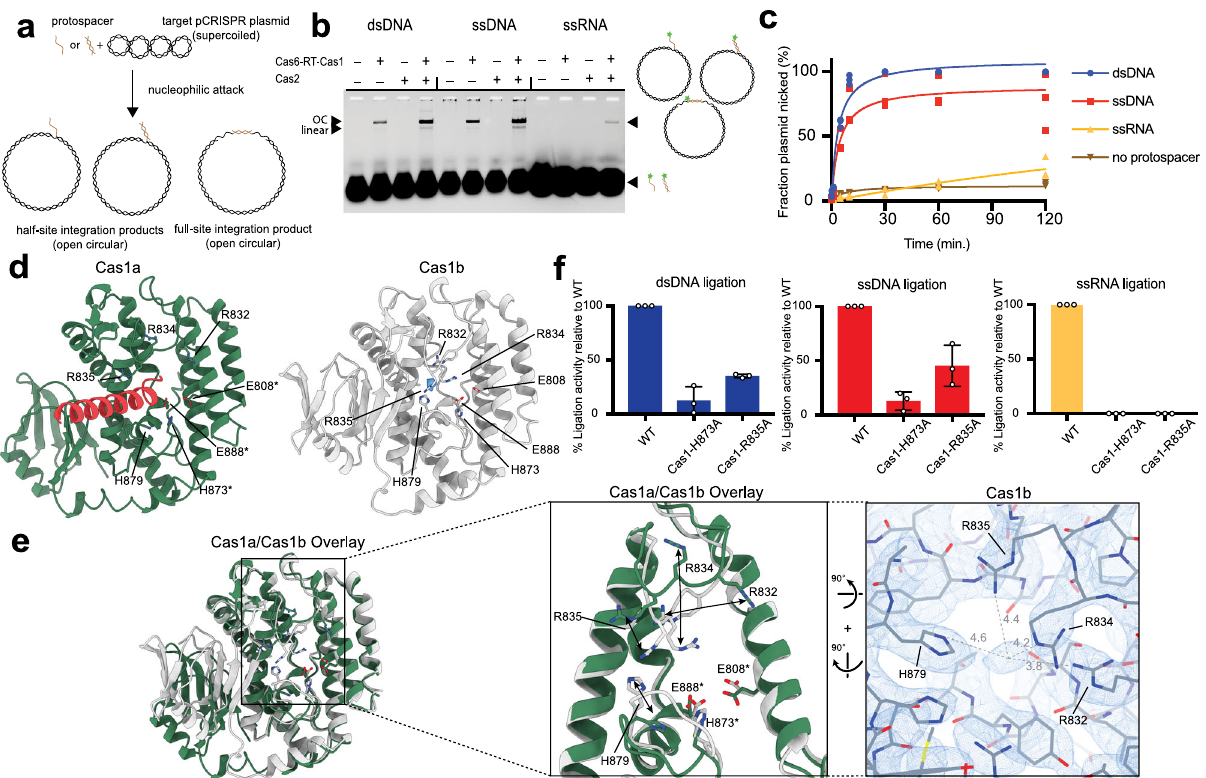
Fig. 2 Cas6-RT-Cas1 — Cas2 catalyzes cleavage-ligation reactions with dsDNA, ssDNA, and ssRNA substrates in vitro. a Schematic of in vitro integration reaction of DNA or RNA protospacer (brown) into a supercoiled pCRISPR plasmid (black) that functions as the target. b Integration assay with fl uorescent 35-nt dsDNA (0.5 µ M), ssDNA (0.5 µ M), and ssRNA (4 µ M) protospacers. Open circular (OC) and linear ligation products are indicated. Star indicates 6-carboxy fl uorescein label. Results are representative of 3 independent experiments. c Time-course integration assay comparing extent of plasmid-nicking with dsDNA, ssDNA, and ssRNA protospacers (35 nt; 4 µ M). Fraction plasmid nicked is calculated as the fraction of open circular products relative to all plasmid ( n = 3 biologically independent experiments). Experimental fi ts are shown as solid lines. Statistical signi fi cance of fraction plasmid nicked after 2 h was assessed using unpaired, two-tailed T tests ( α = 0.05) ( P = 0.000092, dsDNA vs. ssRNA; P = 0.0173, ssDNA vs. ssRNA). Representative gels are shown in Supplementary Fig. 5a. d Comparison of Cas1a (dark green) and Cas1b (white), with RT-helix (red) and unknown density (blue). Active site and surrounding residues are shown in stick con fi guration. Active site residues are labeled with an asterisk *. e Cas1a and Cas1b overlay and closeup of active site. Double-headed arrows indicate large conformational differences. Single-headed arrows indicate 90° rotations. Cryo-EM density shown in blue mesh, distances in angstroms. f Ligation of 35-nt fl uorescent dsDNA (0.5 µ M), ssDNA (0.5 µ M), and ssRNA (4 µ M) protospacers into target pCRISPR by mutant Cas6-RT-Cas1 — Cas2 proteins. Percent ligation activity is calculated as the fraction of fl uorescent products from the mutant Cas6-RT- Cas1 — Cas2 relative to that from the wild-type (error bars, mean ± sd, n = 3 biologically independent experiments). Representative gels are shown in Supplementary Fig. 8c. Uncropped gels and source data for panels c and f are provided as a Source Data fi